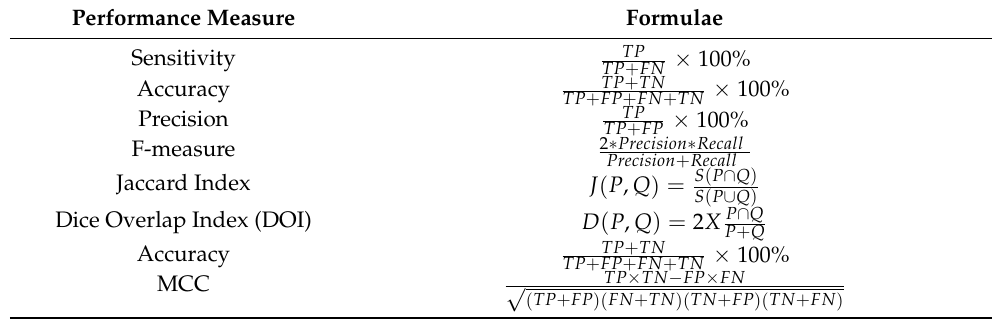
Table 11. Evaluation measures used in the classification frameworks.